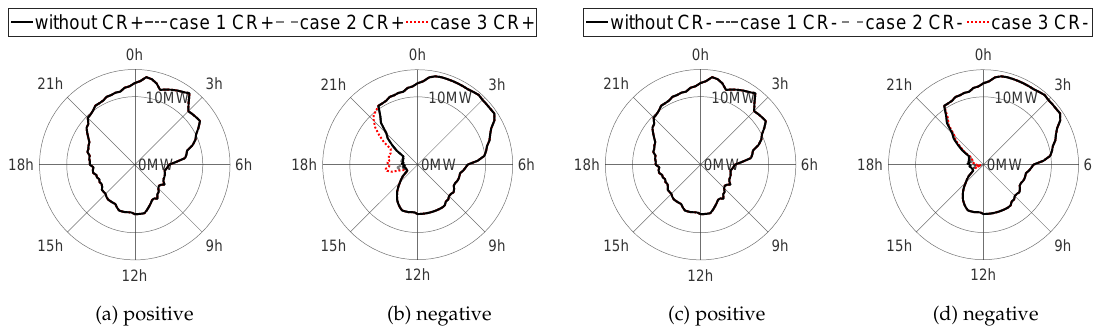
Figure 11. Available ( a , c ) positive and ( b , d ) negative reserve capacity of the electric bus fleet including the response to ( a , b ) positive and ( c , d ) negative reserve power